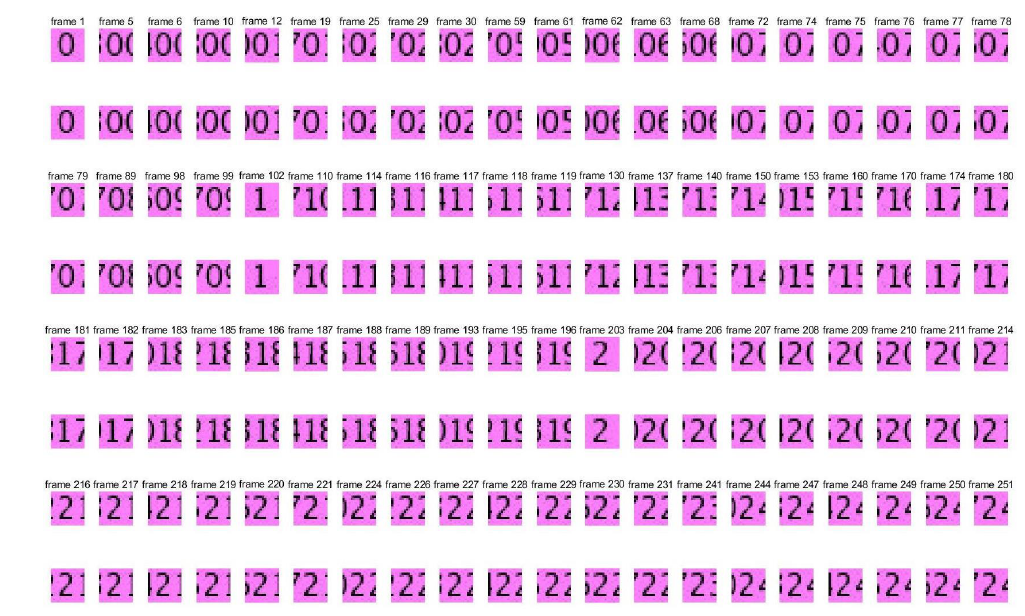
Figure 2. Pictures of watermark 1 and extracted watermark 1. Pictures in the first, third, and fifth lines are the frames in the original watermark video 1, and pictures in the second, fourth, and sixth lines are the frames in the extracted watermark video 1.